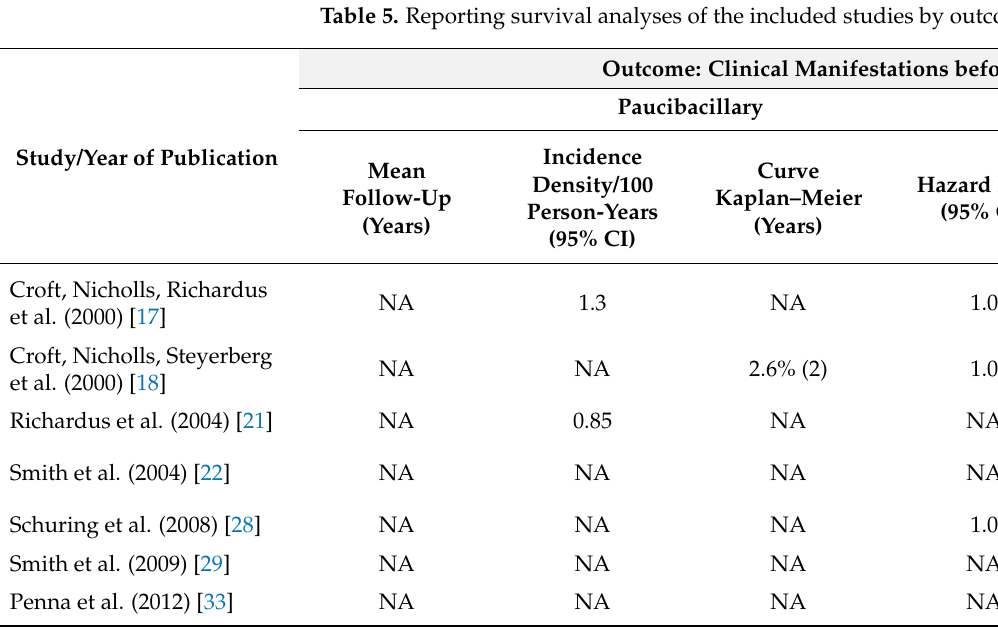
Table 5. Reporting survival analyses of the included studies by outcome clinical manifestations before, during and after treatment—nerve function